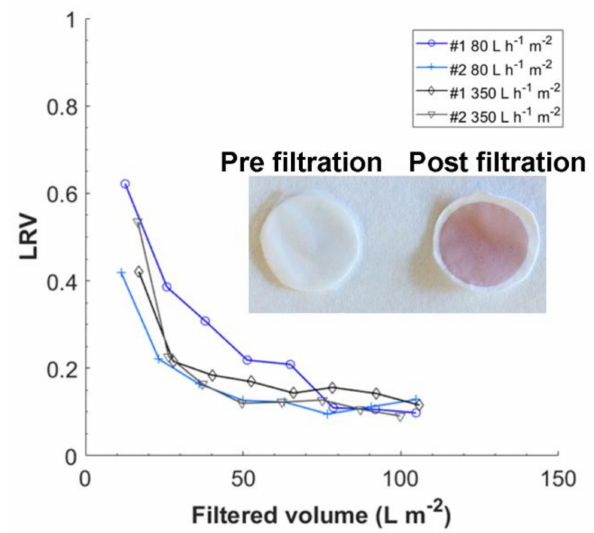
Figure 8. LRV for filtration of 5 nm gold particles at fluxes 80 and 350 L m − 2 h − 1 . Inserted image shows a plain native unused filter pre and prost gold nanoparticle